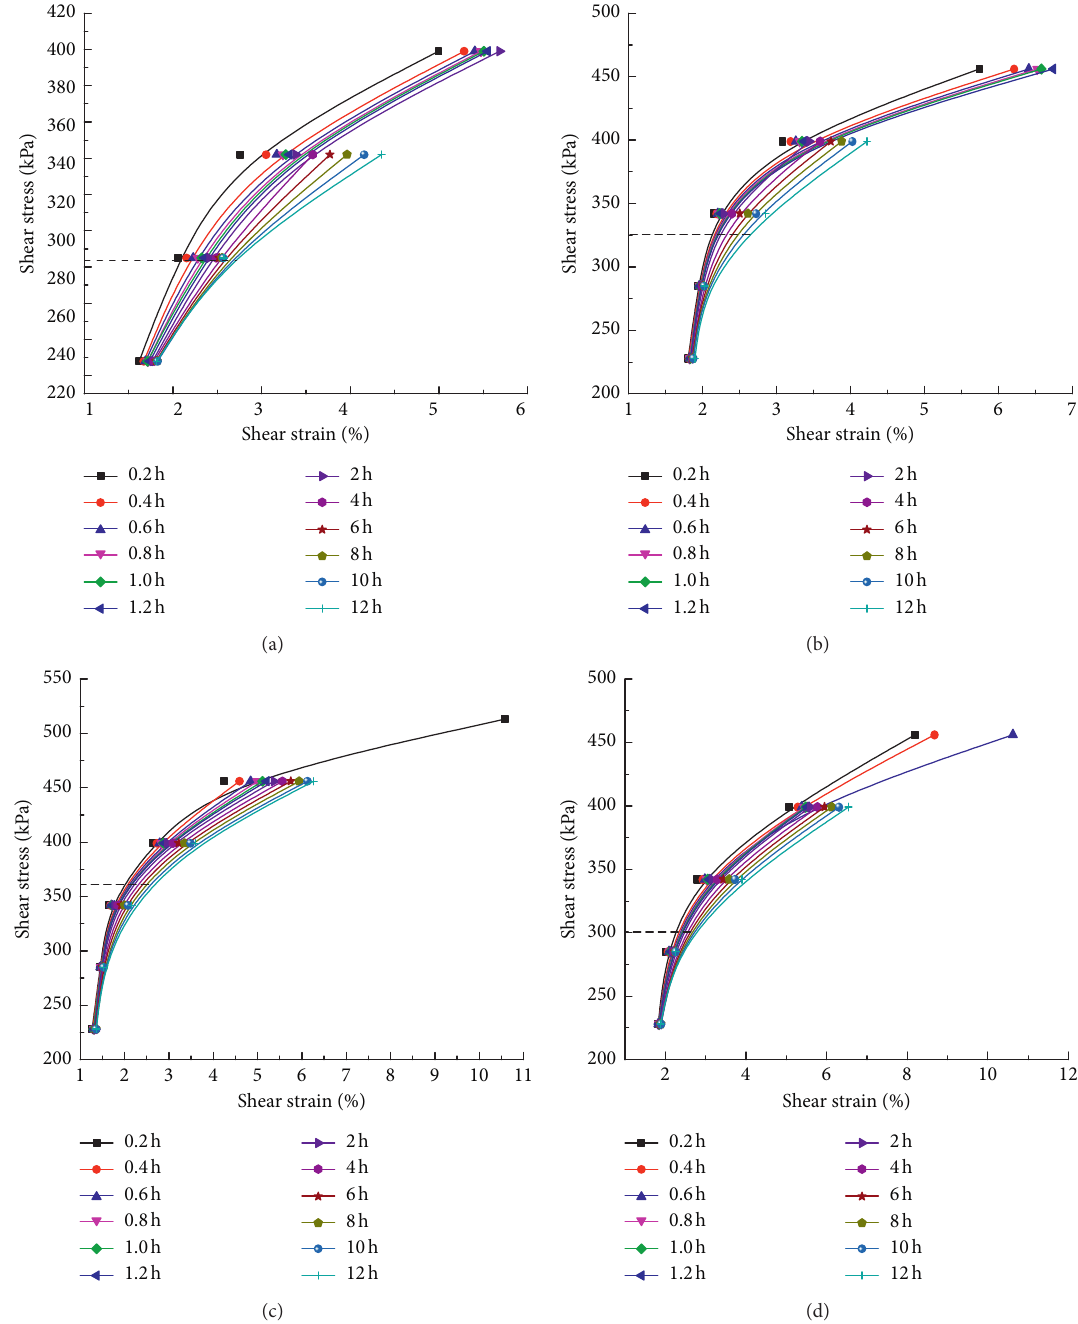
Figure 4: Stress-strain isochronous curves for soil with different fiber contents. (a) Sample A (unreinforced); (b) Sample B1 (fiber content 0.2%); (c) Sample B2 (0.6%); and (d) Sample B3